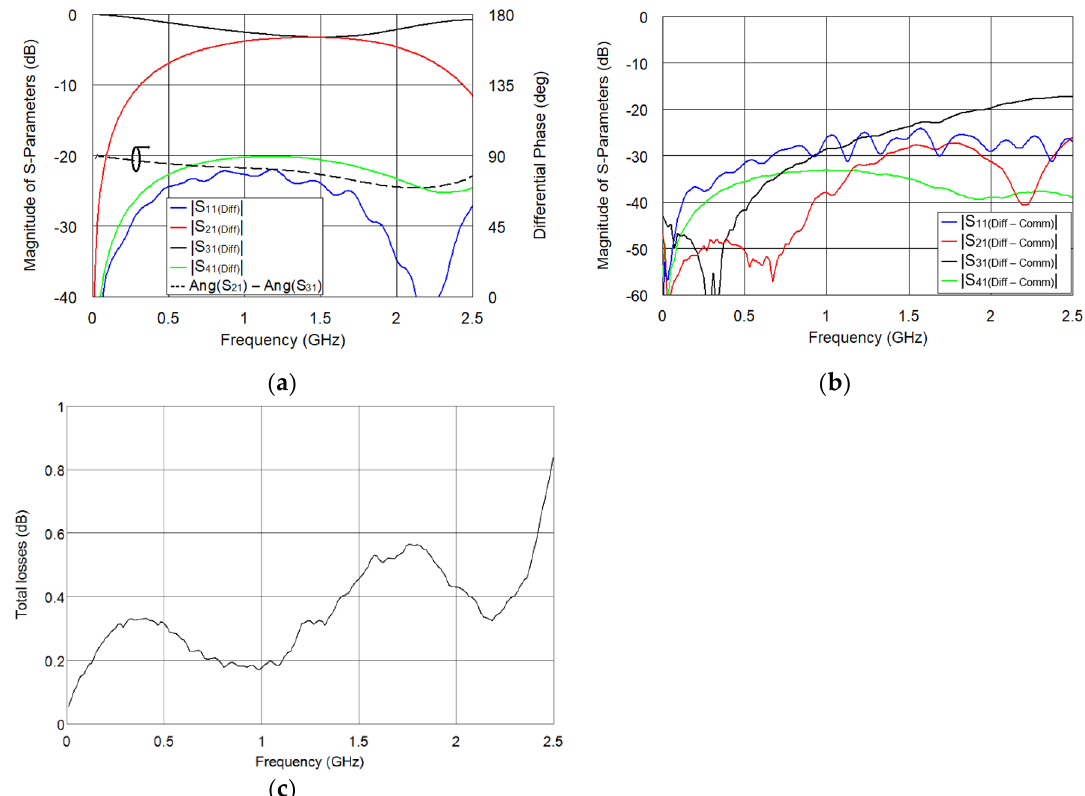
Figure 6. Measured magnitudes of differential S ‐ parameters (solid lines) and phase characteristic (dashed line) (a), differential ‐ to ‐ common mode S ‐ parameters (b) and the measured total losses (c) of the manufactured compensated differential coupled ‐ line directional coupler.